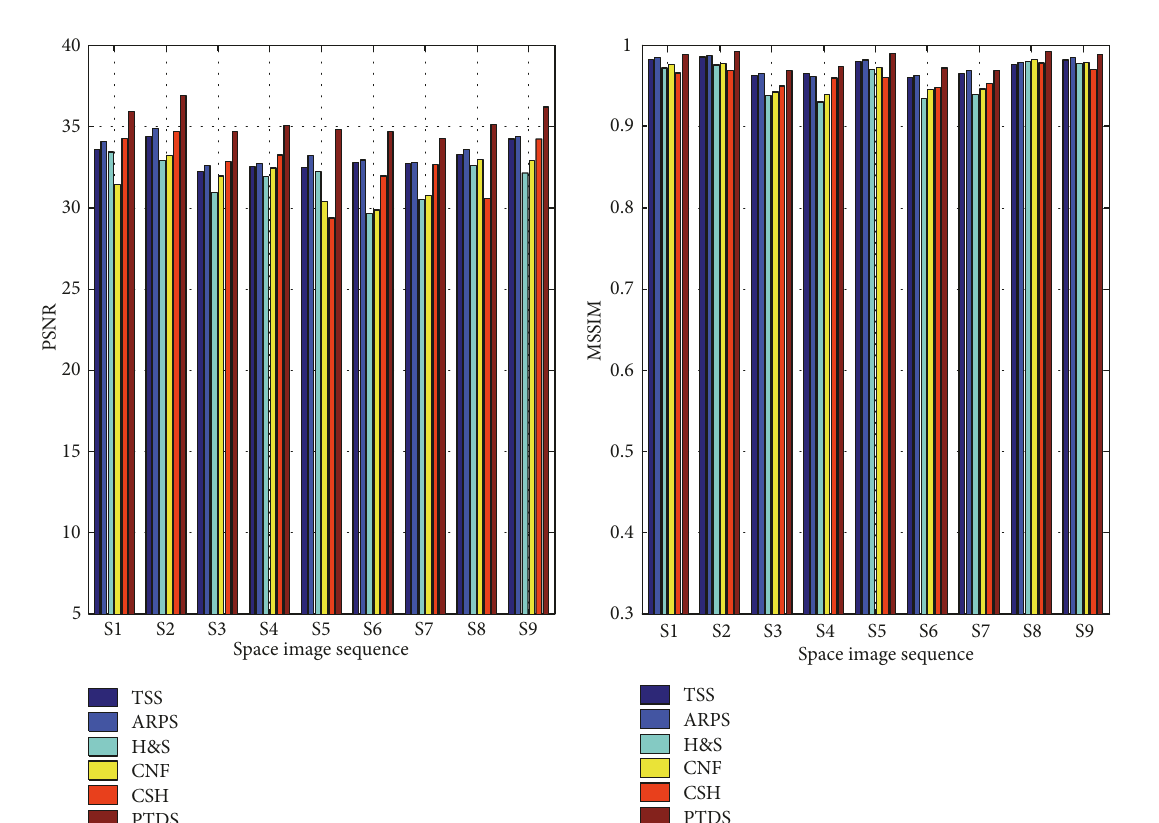
Figure 9: Comparison results of average values in the term of PSNR and